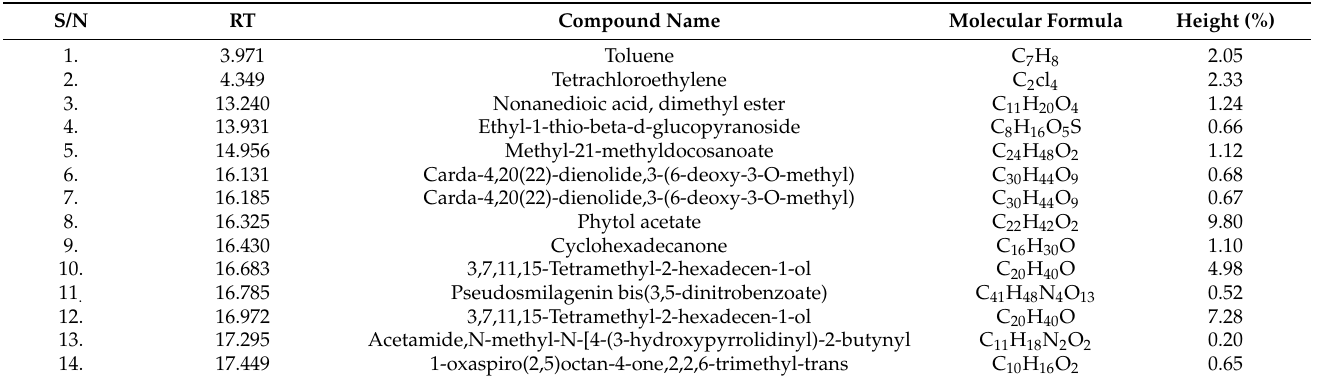
Table 5. Compounds identified in the methanol extracts of D. villosa leaves by GC–MS spectral